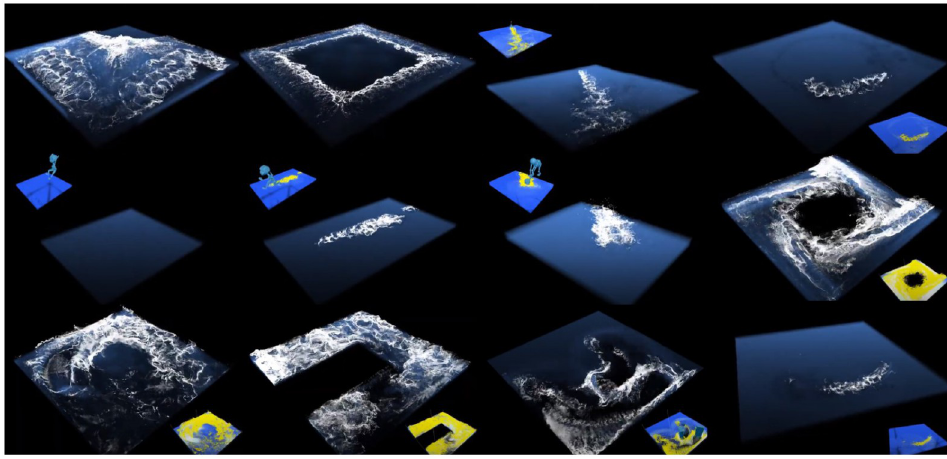
Fig 7. Examples by